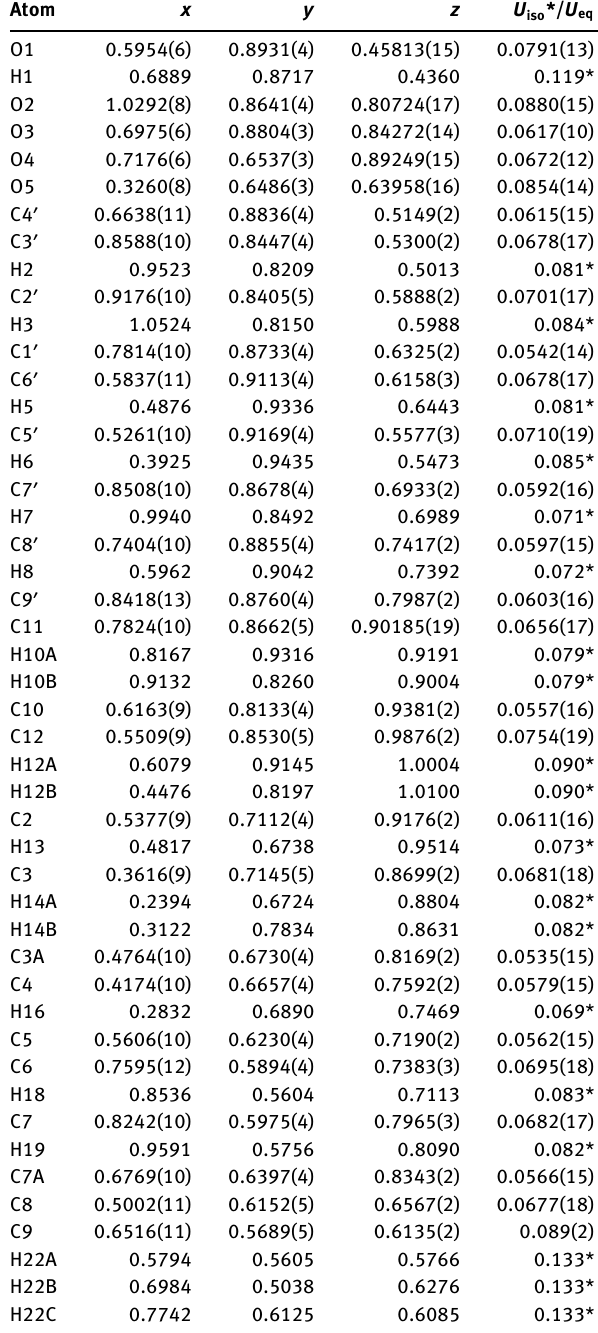
Table 2: Fractional atomic coordinates and isotropic or equivalent isotropic displacement parameters (Å 2